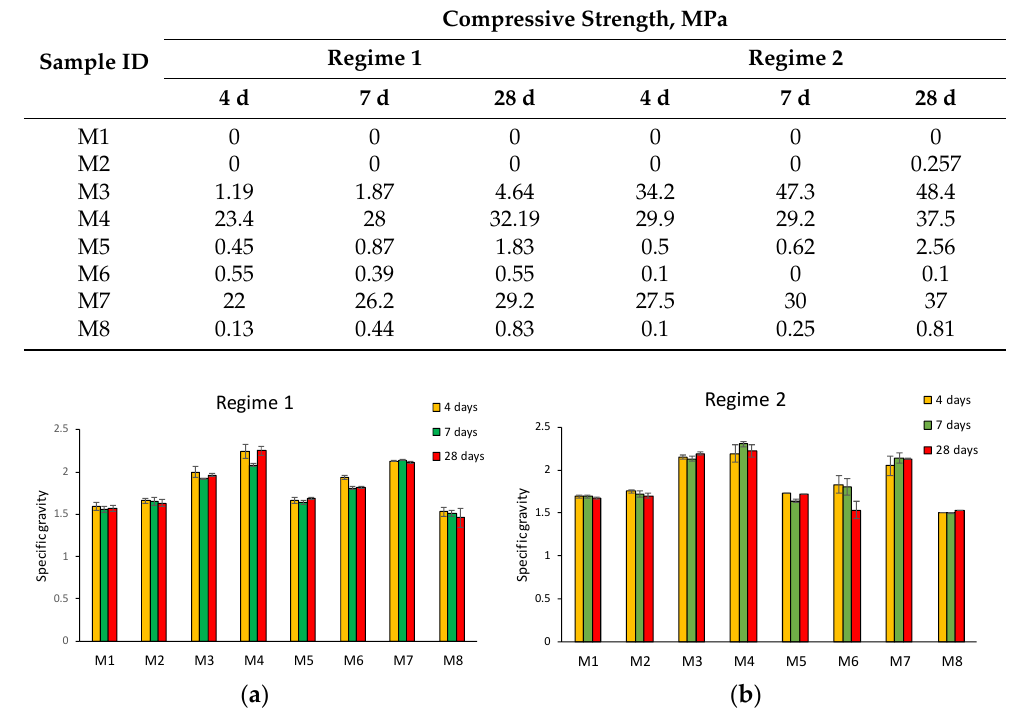
Table 1. Compressive strength of AAC mixes cured in different regimes.